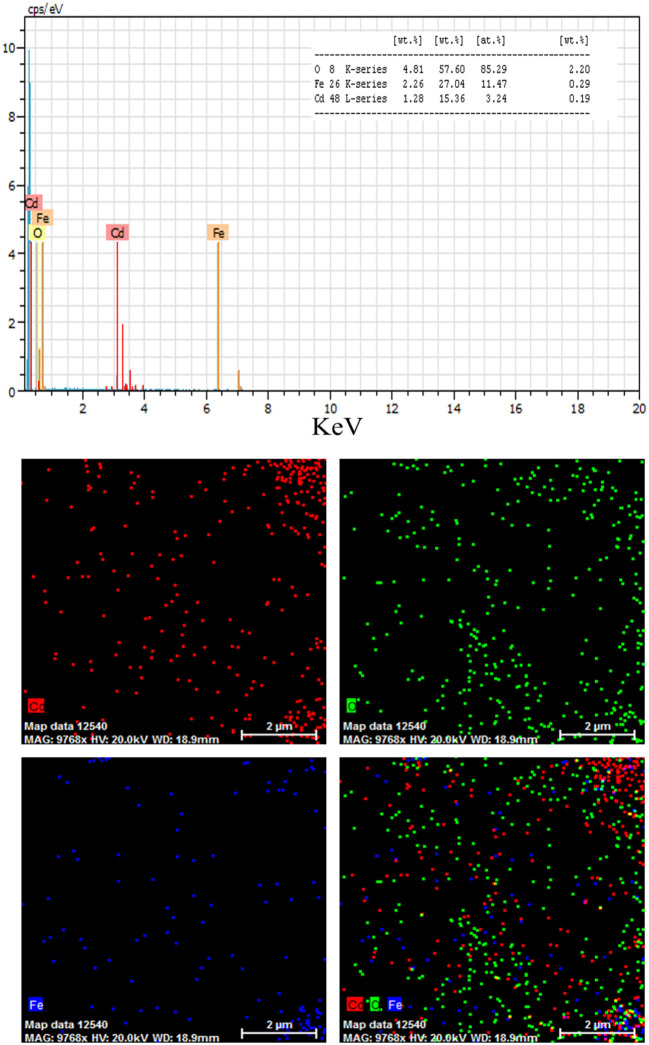
The results of EDS analysis for CdO/Fe3O4 nanoparticles.